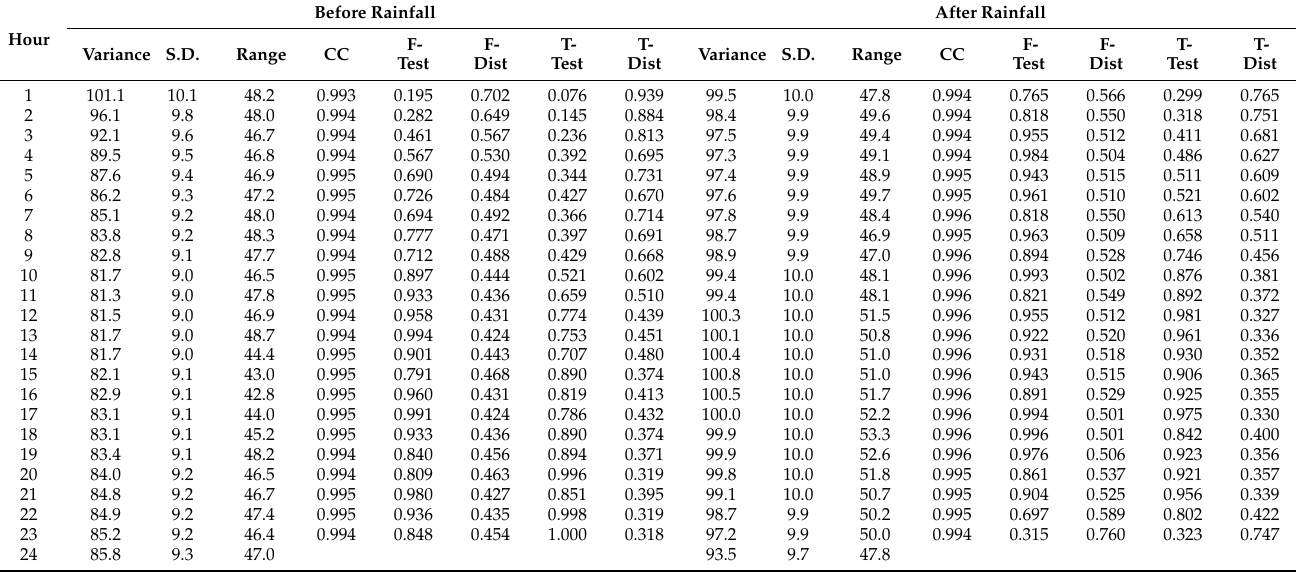
Table 2. Data table of variance, standard deviation, correlation coefficient and T-test and F-test within 24 h before and after